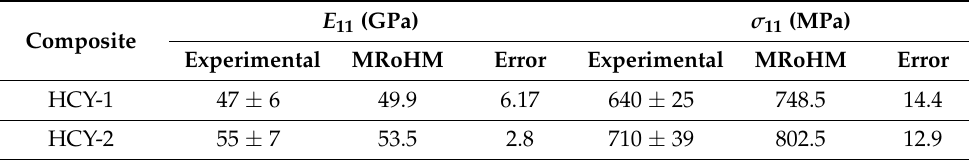
Table 2. Experimental and estimated results of Glass/SS/PA-6 hybrid